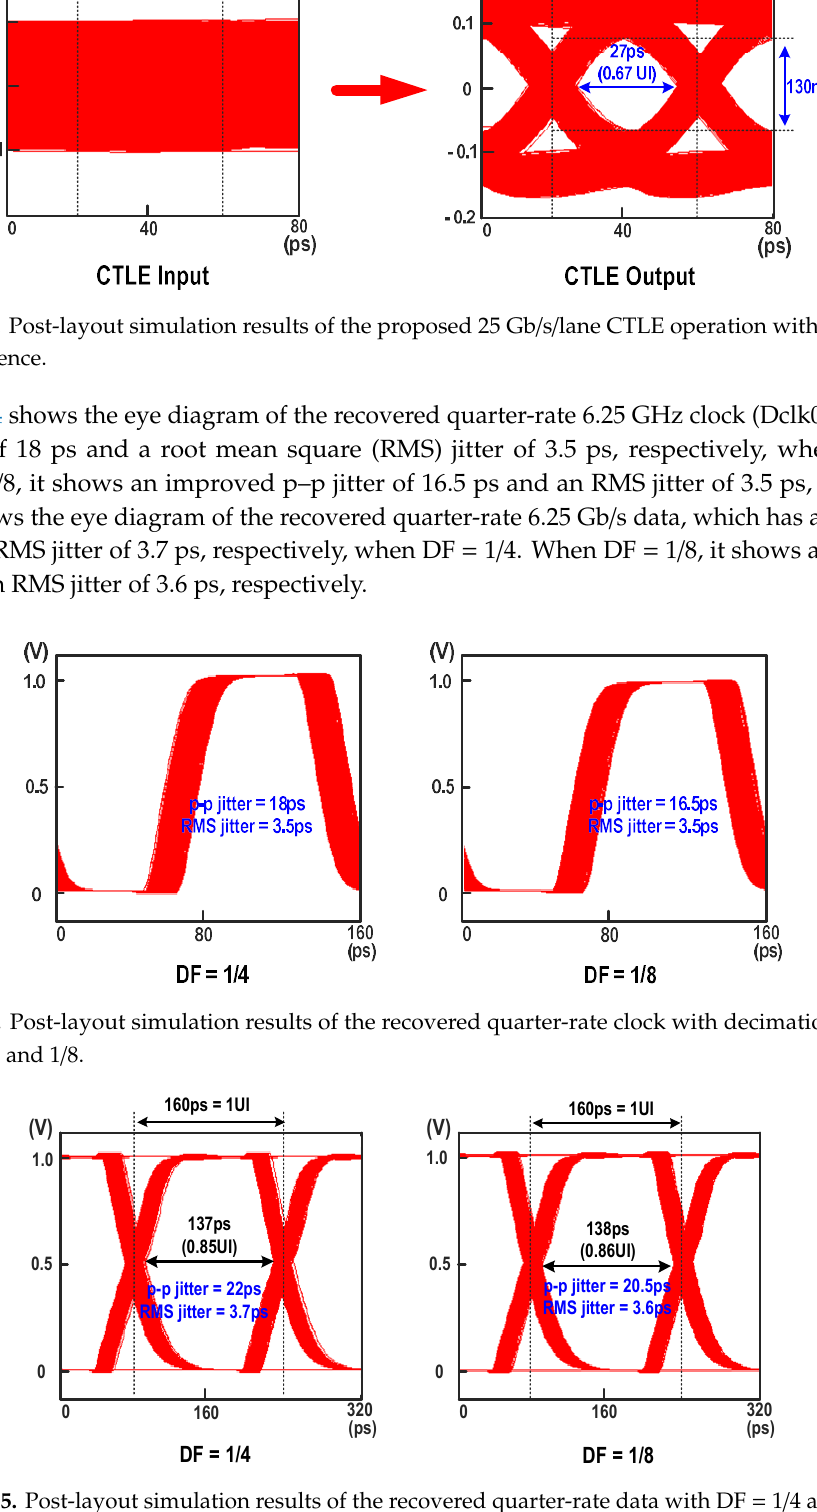
Figure 13. Post-layout simulation results of the proposed 25 Gb/s/lane CTLE operation with PRBS31 data sequence.